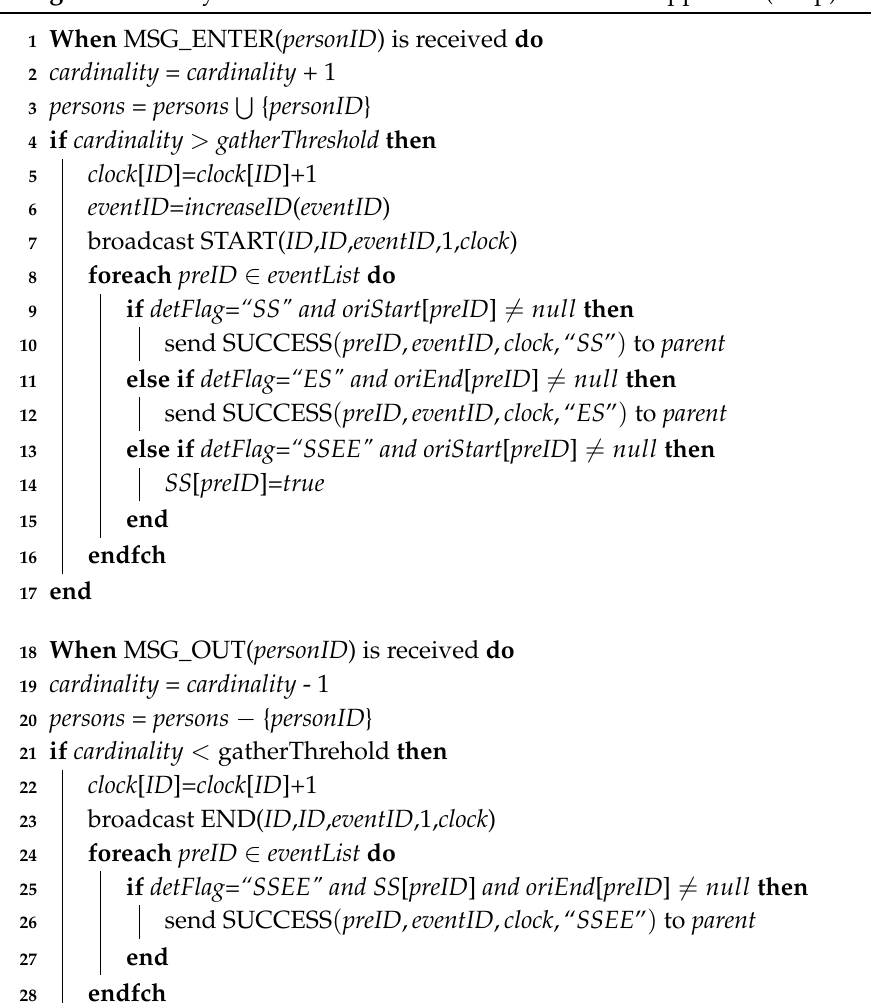
Algorithm 2: Asynchronous Distributed Data Collection Approach